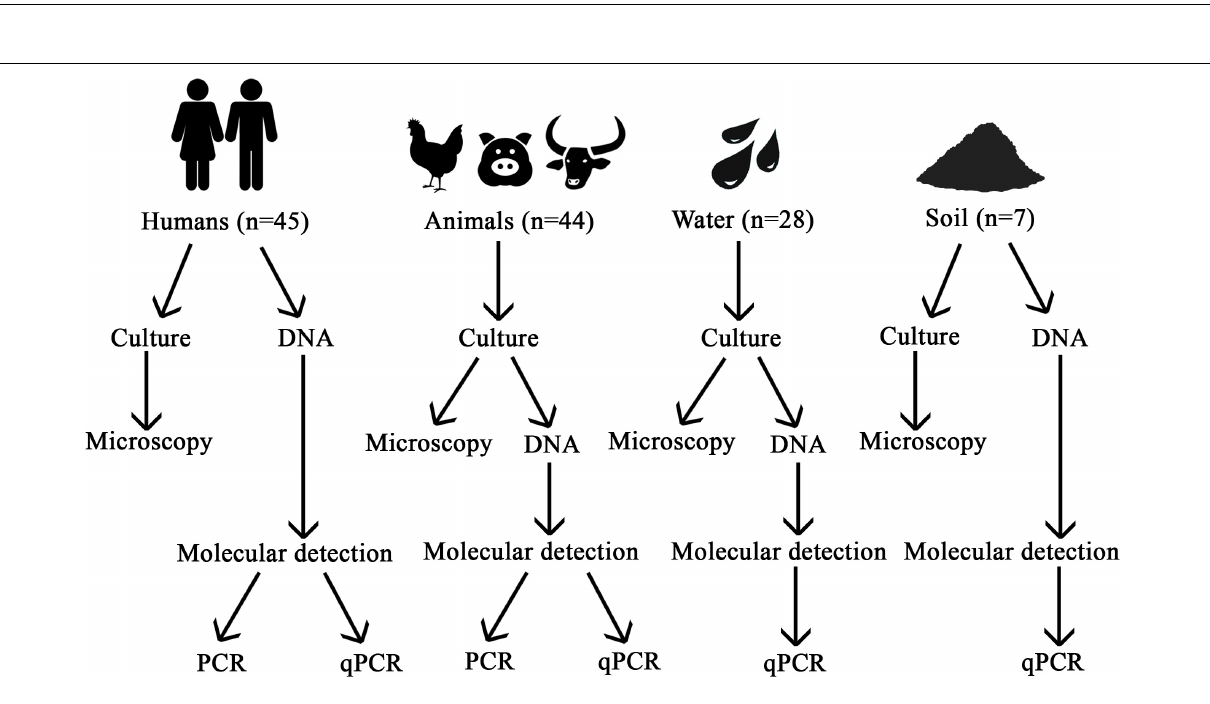
FIGURE 1 | Top right panel: Map of Thailand. Black pin has been placed on Chiang Rai Province. Top left panel: Close-up of Chiang Rai Province (in pale yellow) and the district where sampling took place (in black). Bottom panel: Detail of area of collection used in this study. Geometrical shapes represent households. Stars: Only human stool was collected. Triangles: human stool, animal stool and water were collected. Squares: Human and animal stool was collected. Circles: Human stool and water were collected. Red shapes indicate households, where stool samples were collected from all members.